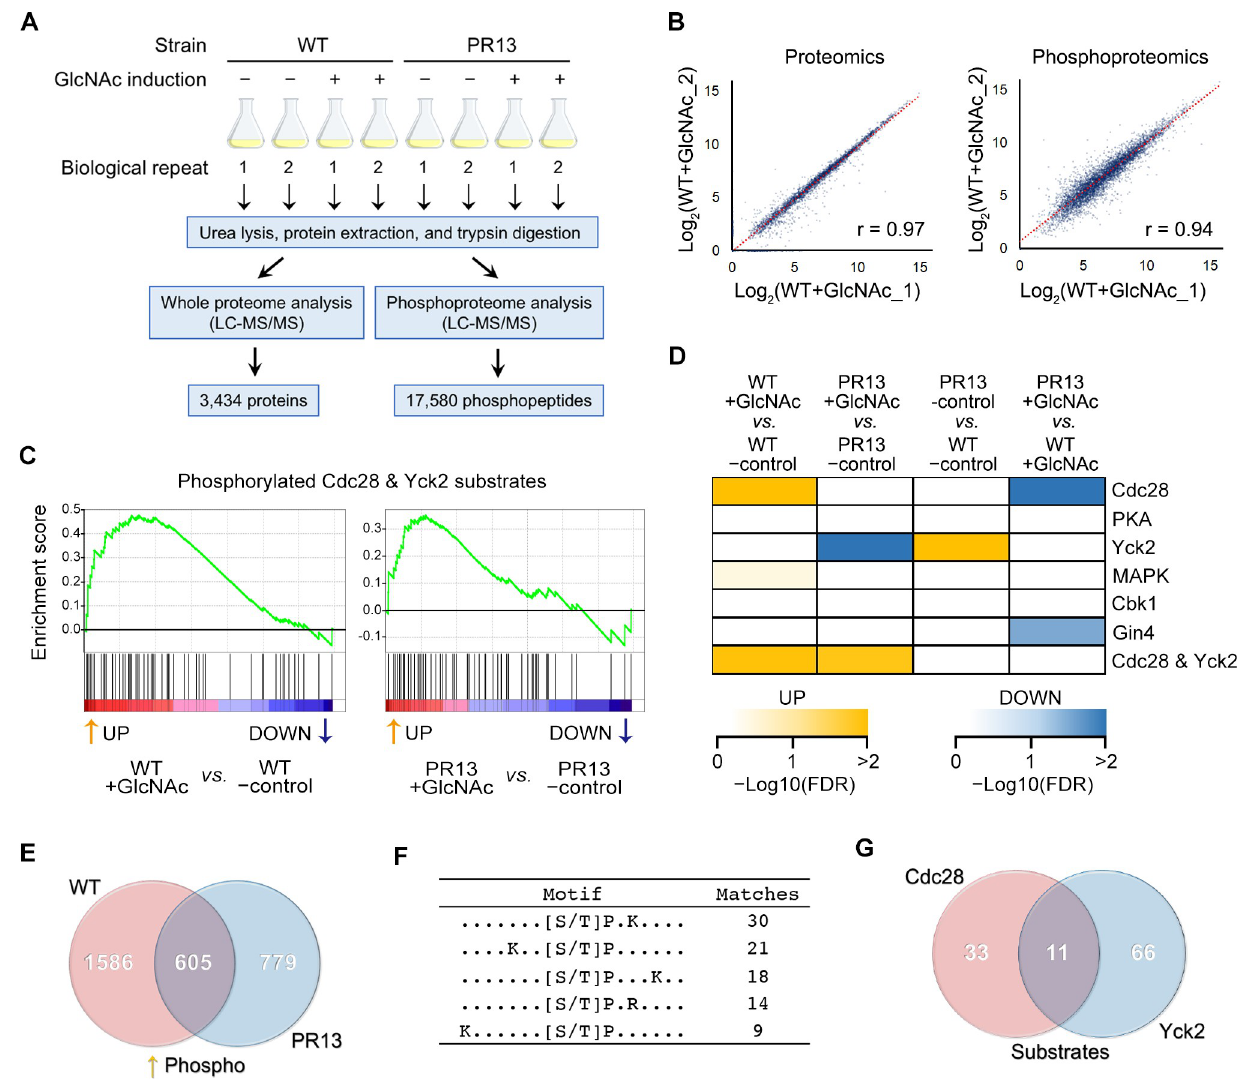
Fig 4. Quantitative phosphoproteomics detected activity of two key protein kinases in hyphal induction. (A) Experimental scheme of parallel proteomic and phosphoproteomic analyses. Cells were grown at 37˚C in liquid galactose medium and then 50 mM GlcNAc was added for 2 h to induce hyphae. For phosphorylation analysis, phosphopeptides were enriched by polymer-based metal-ion affinity capture (PolyMAC). There were 2 biologically independent replicates for each condition. (B) Representative null comparisons of the biological replicates show high reproducibility. We compared the replicate data of WT+GlcNAc_1 and WT+GlcNAc_2 from both whole proteome and phosphoproteome. (C) Representative results of kinase-substrate enrichment analysis. Gene set enrichment analysis (GSEA) algorithm [50] was used to identify significantly enriched or depleted groups of phosphorylated substrates. The potential substrates of both Cdc28 and Yck2 kinases were more phosphorylated (up-regulated) during the hyphal induction in the WT and PR13 cells. (D) The color-coded diagram illustrates changes of the selected kinase activities indicated by the scale bar at the bottom ( < 25% false discovery rate [FDR]). Kinase activity inference was based on the collective phosphorylation changes of their identified substrates. (E) Venn diagrams of phosphopeptides upregulated during hyphal induction (log 2 fold change > 0.5). Note that 605 phosphopeptides were upregulated in both WT and PR13 strains. (F) Overrepresented motifs were extracted from the 605 phosphopeptides, using the motif-x algorithm [88] (p < 10 − 6 ). 44 phosphopeptides had the Cdc28 consensus motif ([S/T]-P-x-K/R) indicating they were potential substrates. (G) Venn diagrams of the upregulated Cdc28 substrates ([S/T]-P-x-K/R) or Yck2 substrates (S/T-x-x-[S/T]). 11 phosphopeptides were potential substrates of both Cdc28 and Yck2 kinases. replicate data of WT cells treated with GlcNAc from both the whole proteome and the phos- phoproteome. The null comparisons of the biological replicates showed high correlations (r > 0.9) (Fig 4B). We first examined the phosphorylation status of Efg1, since genetic studies implicated this TF as being a target of PKA and Cdc28 kinases on positions T179 and T206